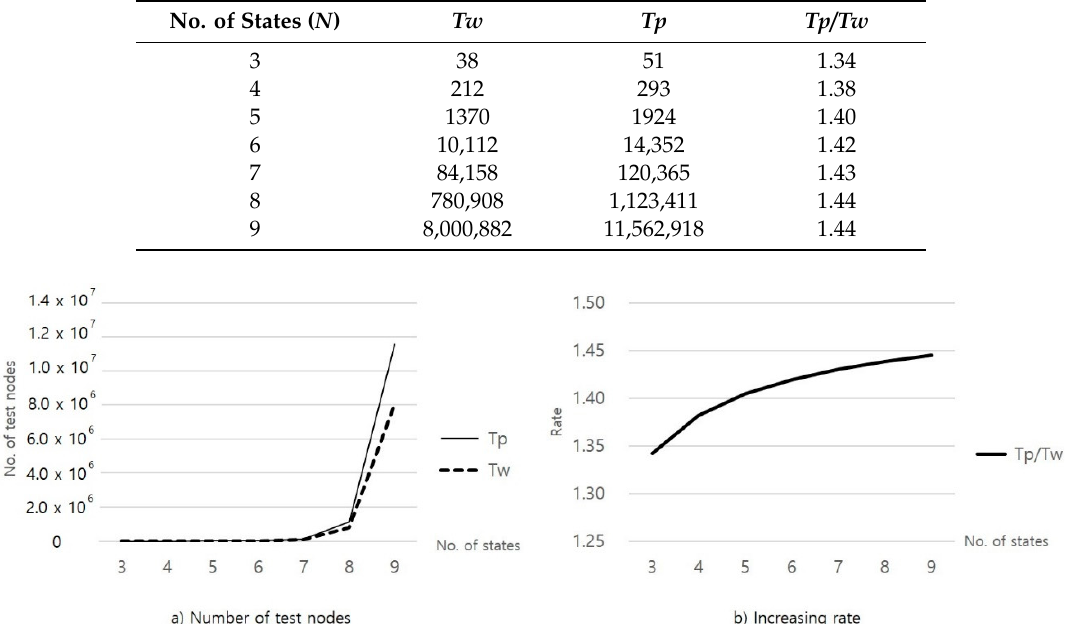
Figure 8. Testing time of two methods and testing time increasing rate of Tp by number of states.